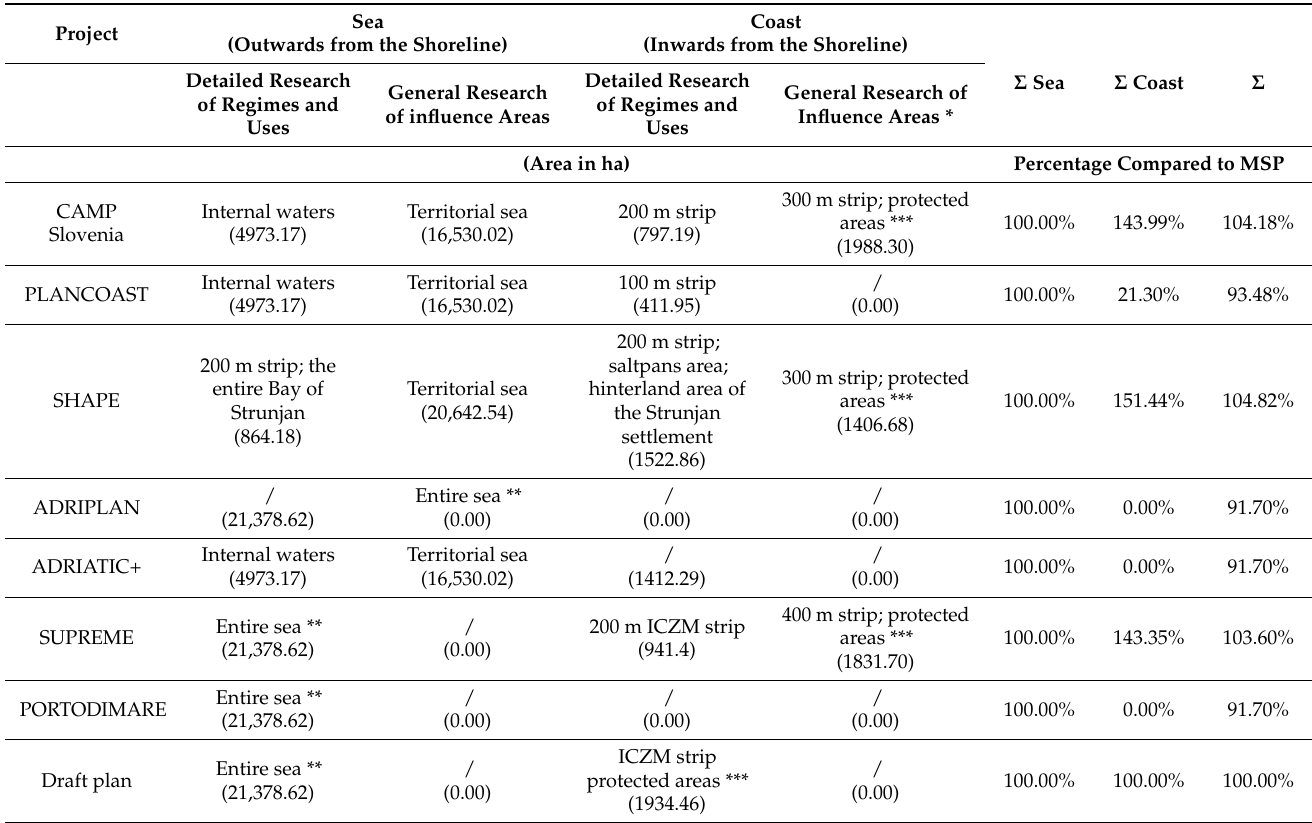
Table 3. Application areas of individual projects, surface of the project application areas, and the share of total area in relation to the maritime spatial plan